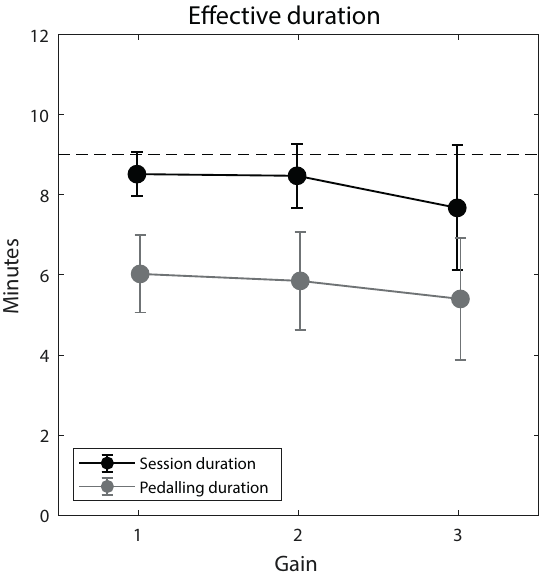
Figure 6. Effective duration of virtual biking sessions (black data points) across the three gain levels. Also shown is the effective pedalling duration (gray data points). The dashed line indicates the maximal session duration. Error bars are 99% confidence intervals of the